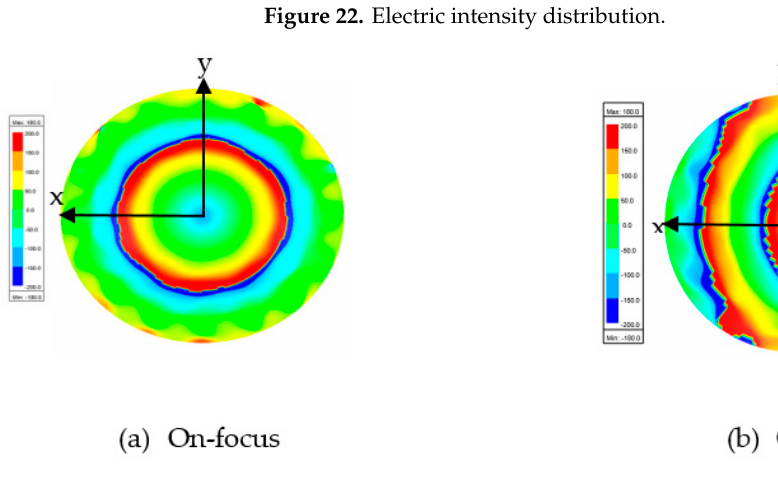
Figure 23. Electric phase distribution.